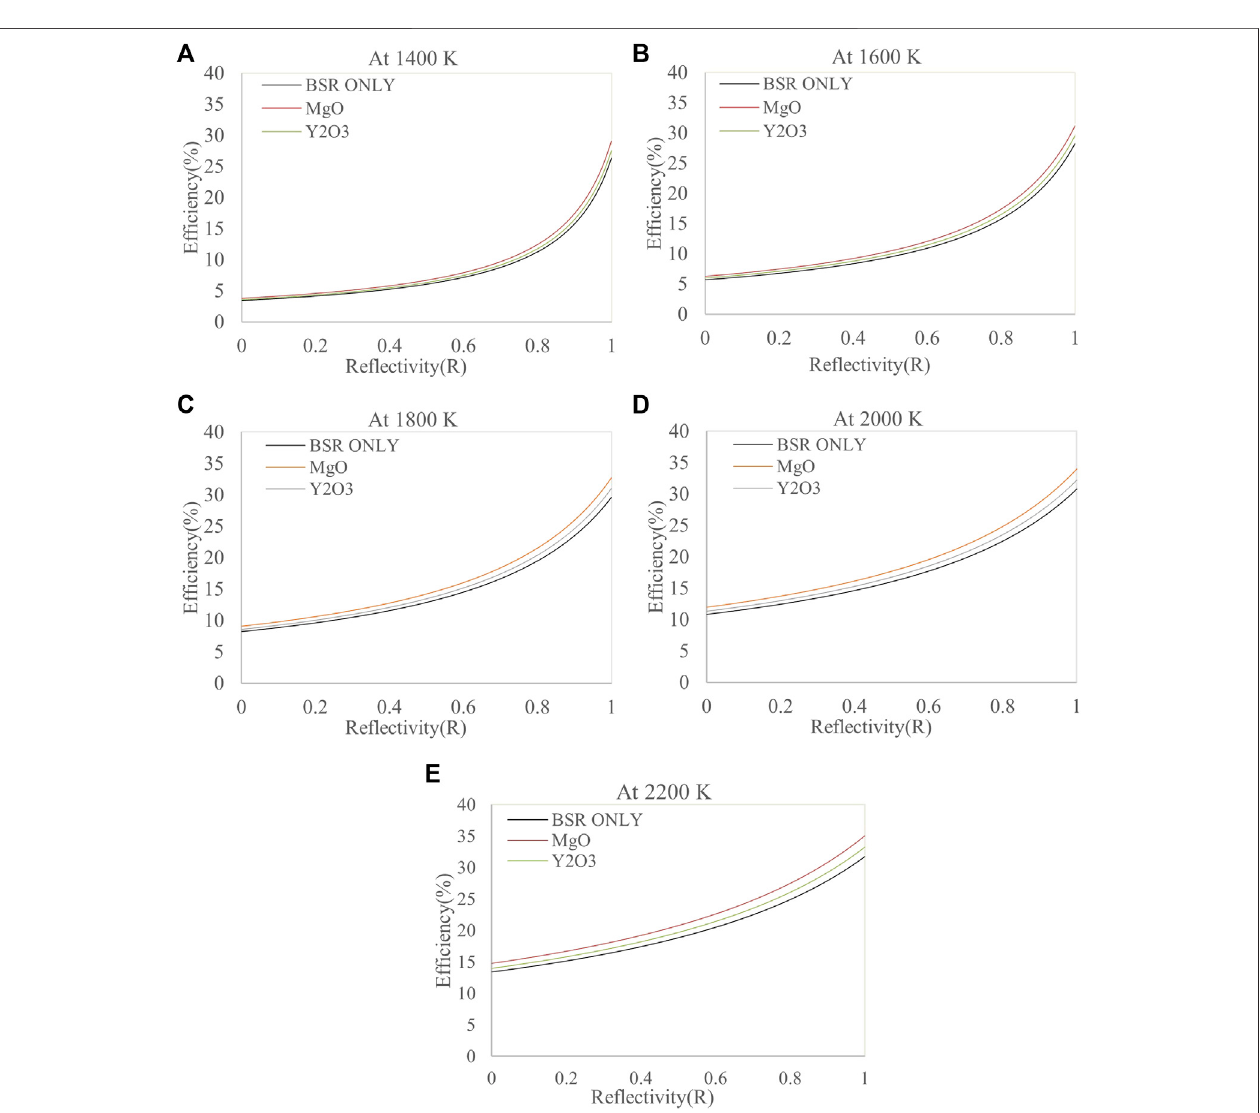
FIGURE 14 | (A – E) Effect on ef fi ciency improvement with BSR Only, Y 2 O 3 , and MgO spectral fi lters at the temperatures of 1400, 1600, 1800, 2000, and 2200 K.